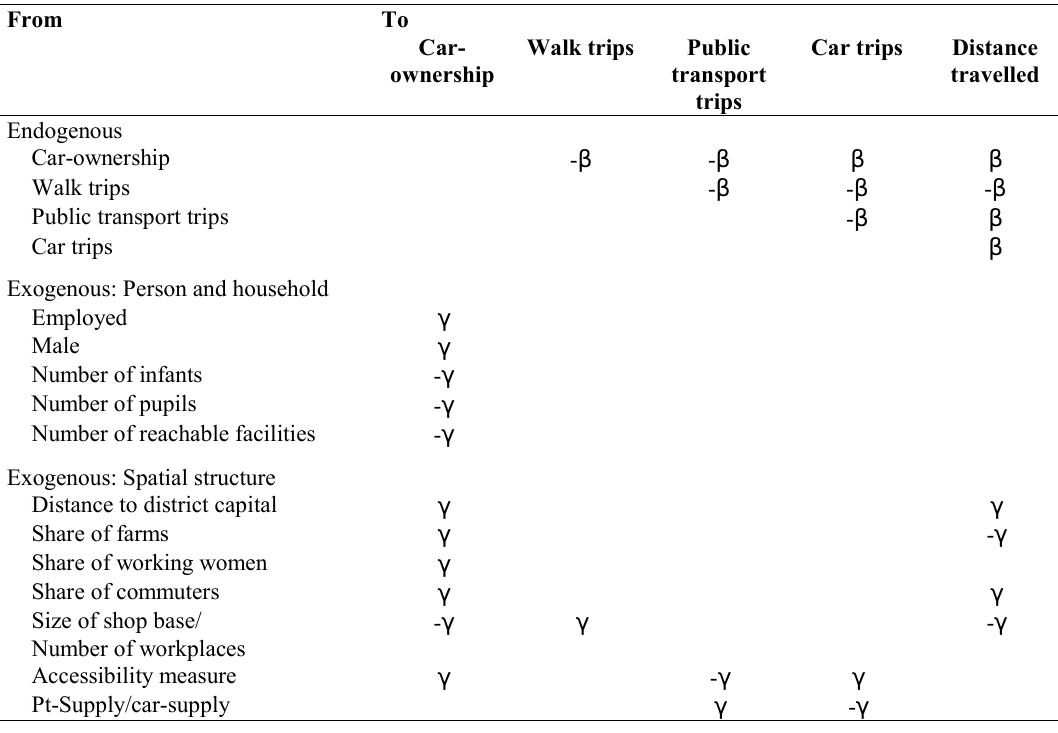
Table 4. Initially postulated direct effects of the two